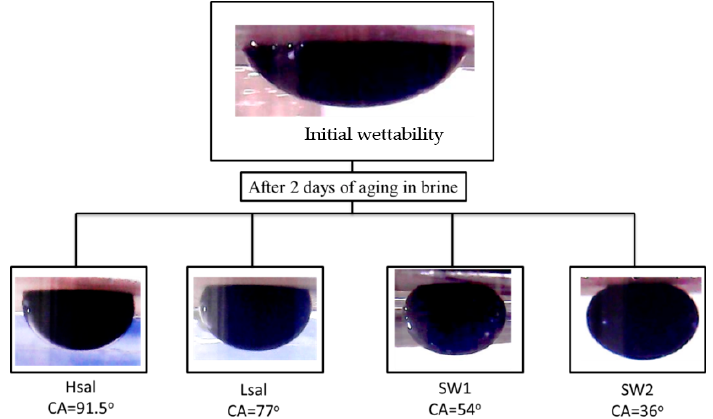
Figure 10. Sample images of pendant oil drops during CA measurements of Case 4 (oil wet) calcite samples in crude oil and treated with different brines for two days.